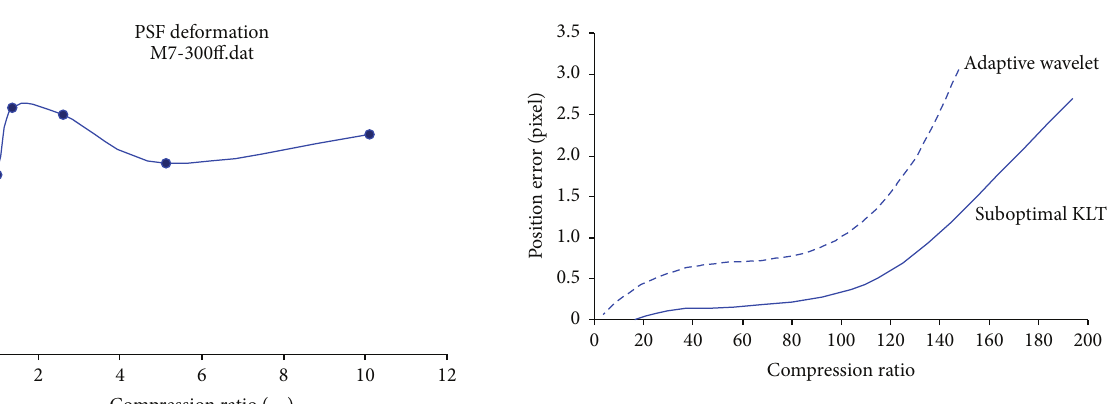
Figure13:ComparisonastrometryerrorfortheKLTandJPEG2000